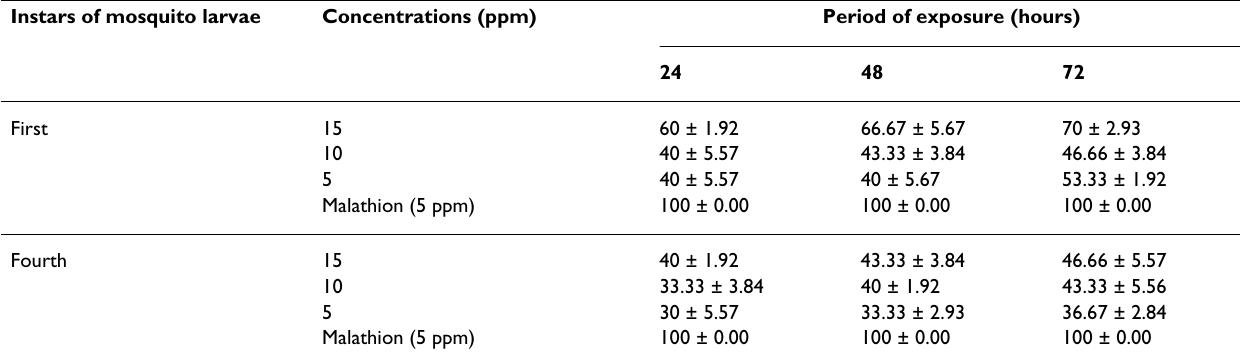
Table 3: The larvicidal potentiality (mean mortality ± standard error) of different concentrations of chloroform:methanol (1:1, v/v) extract of the green berries of S. villosum and a synthetic insecticide, Malathion, on first and fourth instars larvae of S. aegypti . For first instar larvae: t = 2.07 NS , 3.14*, 7.56* (between 15 and 10 ppm at 24, 48 and 72 hours); t = 5.2*, 26.62*, 13.99* (between 15 and 5 ppm at 24, 48 and 72 hours). For fourth instar larvae: t = 2 NS , 1.99 NS , 0.91 NS (between 15 and 10 ppm at 24, 48 and 72 hours); t = 1.73 NS , 1.89 NS , 1.82 NS (between 15 and 5 ppm at 24, 48 and 72 hours). * denotes significant ( p < 0.05); NS, not significant ( p > 0.05). Table value = 2.92 at five degrees of freedom. M, mortality (%); SE, standard error.